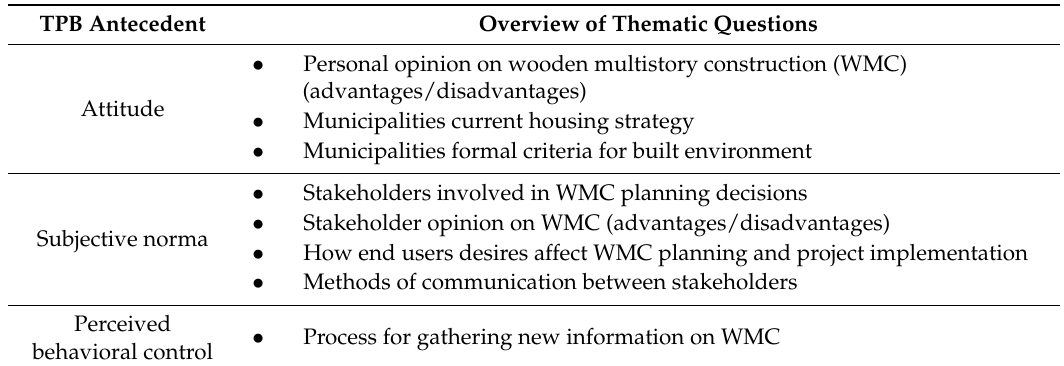
Table 1. Interview questionnaire theory of planned behavior (TPB) themes and their guiding concepts. TPB